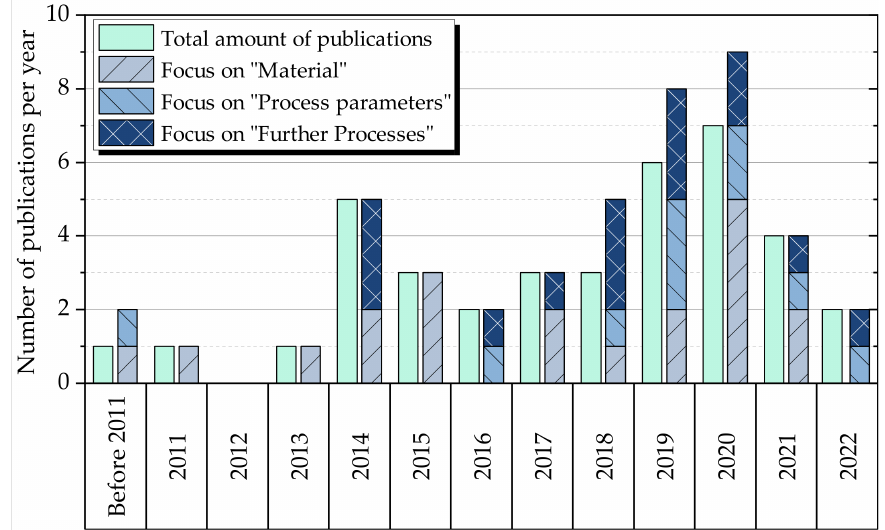
Figure 6. Illustration of the examined publications sorted by years. In addition, we assigned the publications to the corresponding main group labels. Since one publication can be assigned to various foci groups (e.g., material and further processes), its cumulation (right bar) sometimes exceeds the total amount of papers (left bar). The publications from 2022 include only those published up to the month of June.